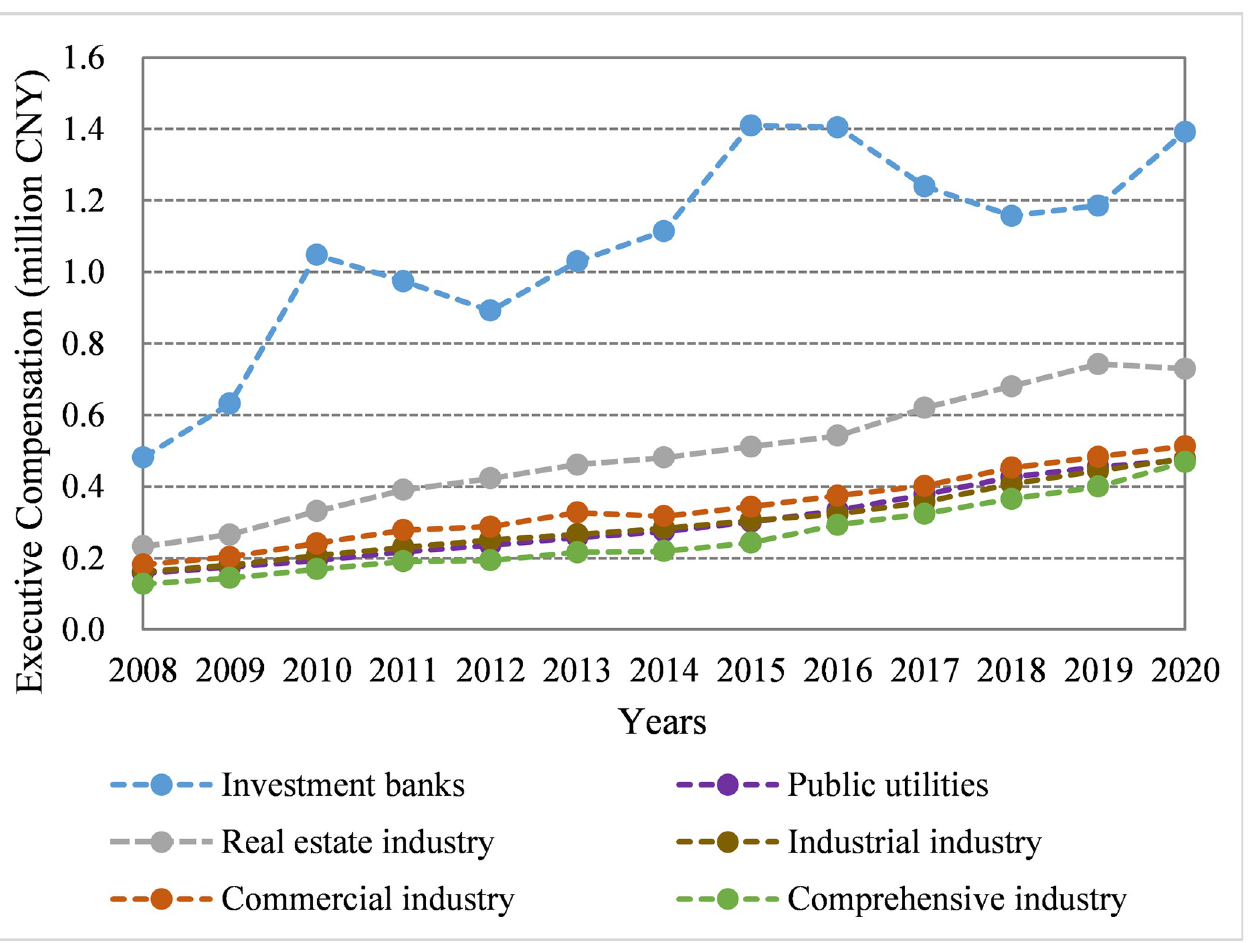
Fig 1. Average monetary compensation of executives in China by industry.